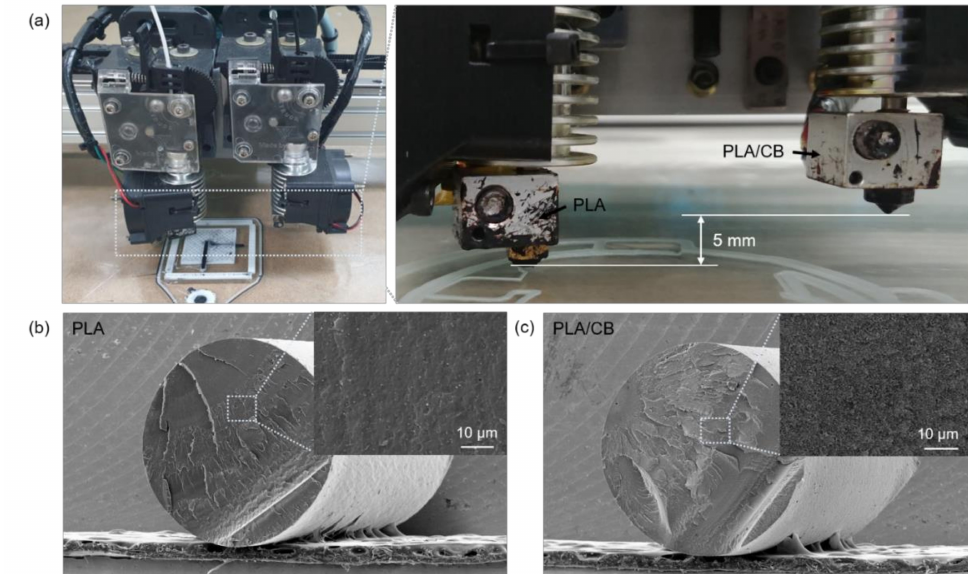
Figure 1. ( a ) Homemade fused deposition modeling (FDM) 3D printer (left) equipped with a dual nozzle extruder (right) injecting polylactic acid (PLA) and PLA/carbon black (CB) filaments; cross- sectional scanning electron micrographs of the ( b ) PLA; and ( c ) PLA/CB